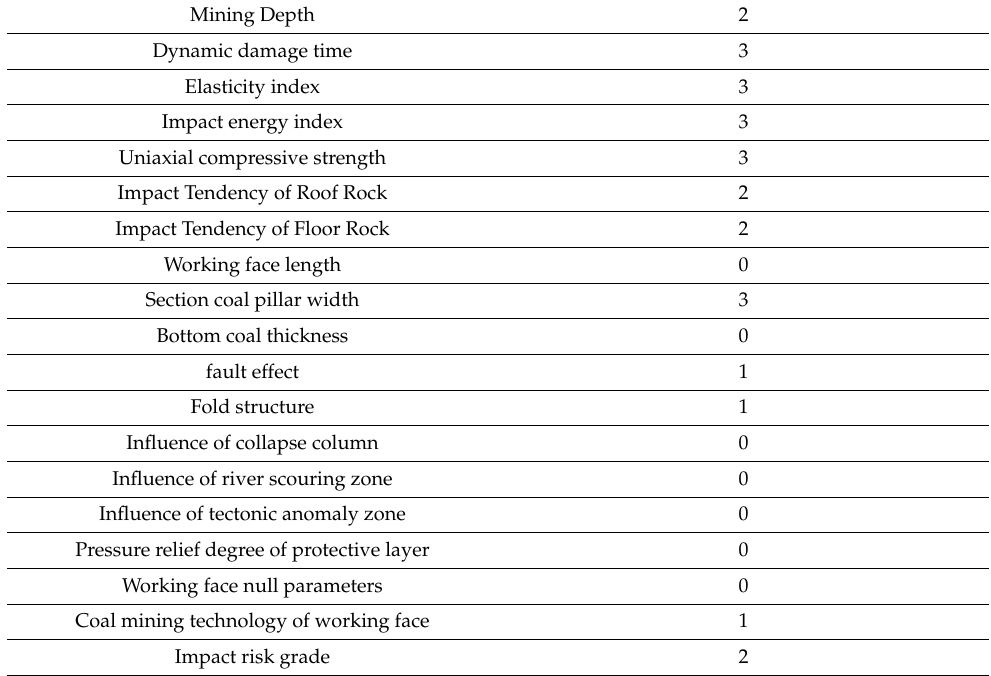
Table 2. 2-1 Quantitative value of coal bed input